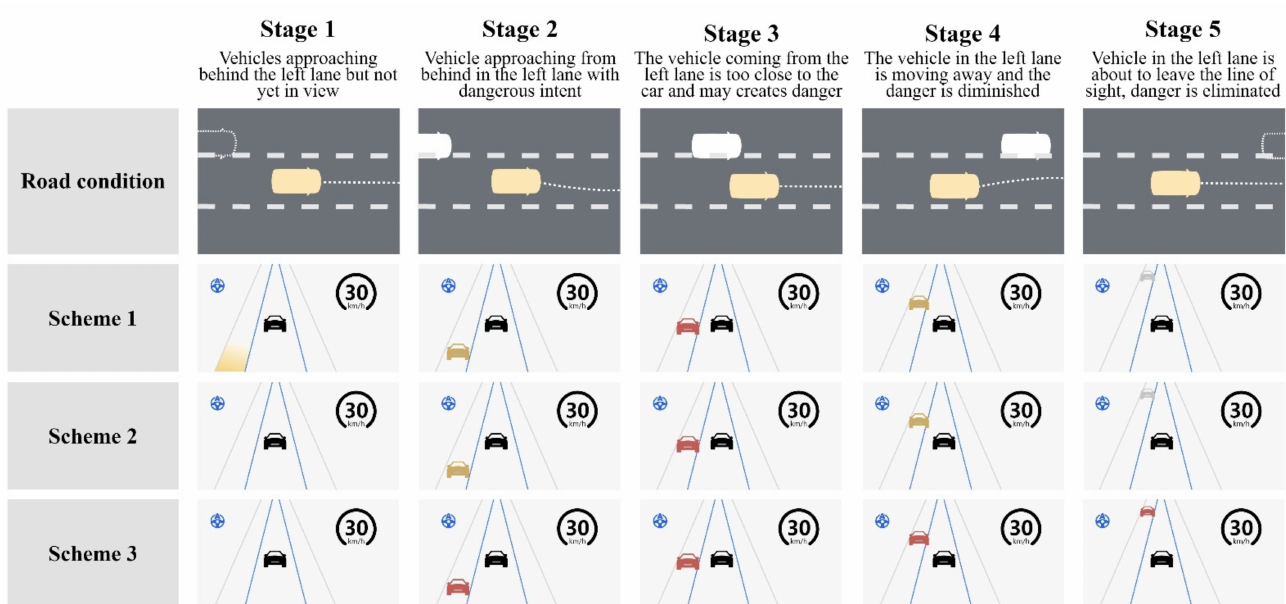
Figure 5. Low-fidelity prototype of the testing interface.